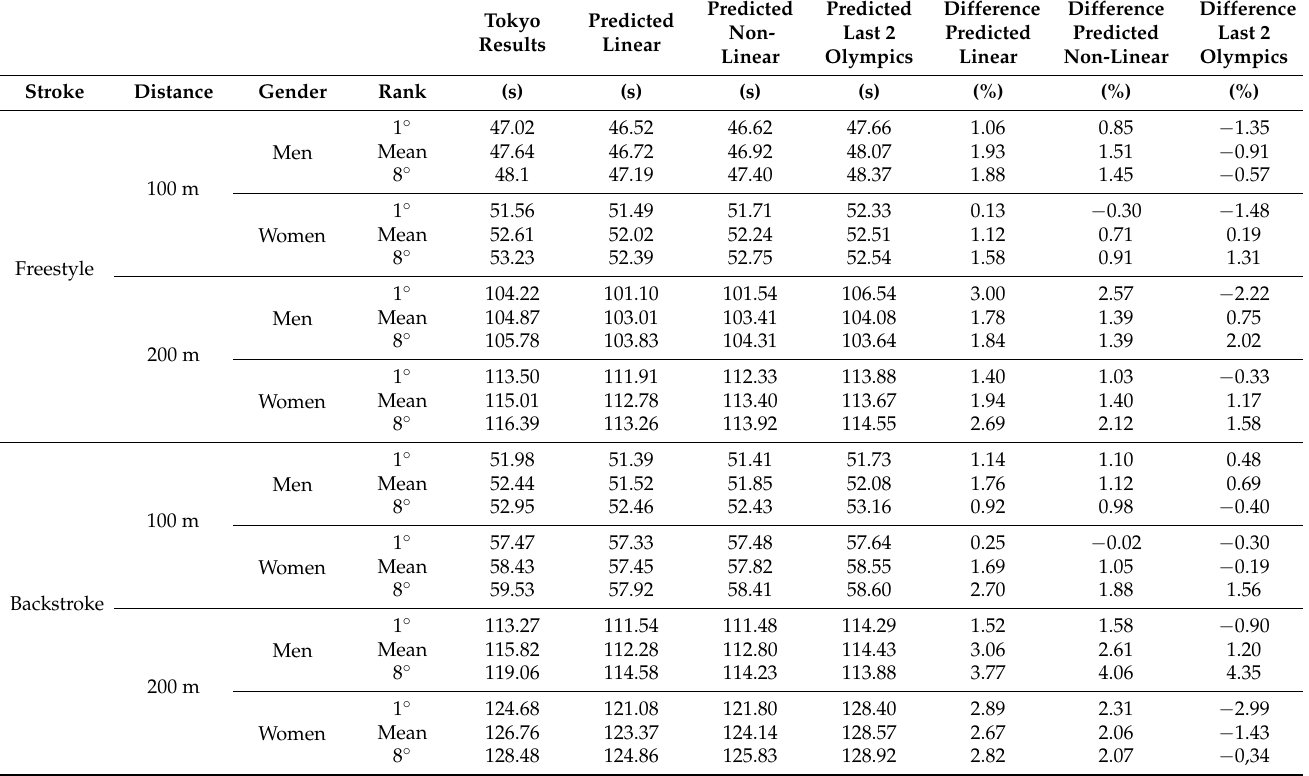
Table 3. Tokyo 2020 predicted and actual competition’s times for men and women 100 m and 200 m Freestyle and Backstroke, with percentage difference between Tokyo and predicted times. Predicted Predicted Difference Difference Difference Tokyo Predicted Non- Last 2 Predicted Predicted Last 2 Results Linear Linear Olympics Linear Non-Linear